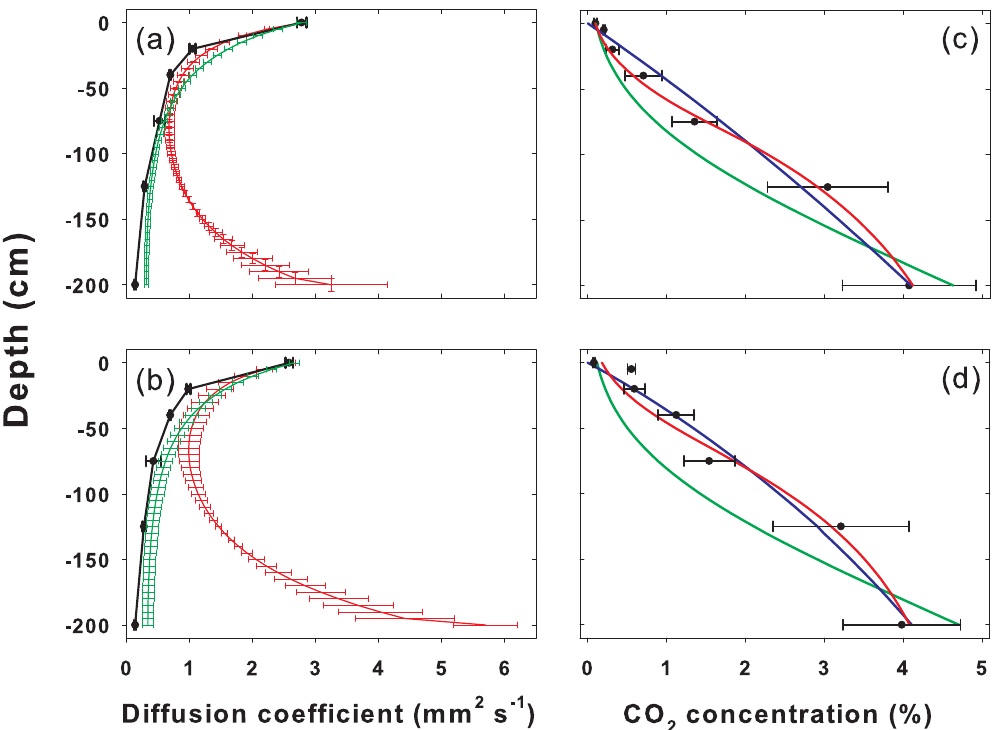
Fig. 3. Left panels: mean ( ± SE, n =3) dry (a) and wet season (b) physically modeled ( • ), unconstrained ( – ) and constrained inversely modeled ( – ) diffusion coefficients. Right panels: mean measured ( • , ± SE, n =3) and interpolated (SE not shown for clarity of the figure, range between 0.02 and 1.01 %) CO 2 concentrations in soil air during dry (c) and wet season (d) using the sigmoidal function with an unconstrained fit parameter choice ( – ), the sigmoidal function with a constrained fit parameter choice ( – ; see Sect. 2.2.4) and an exponential function ( –